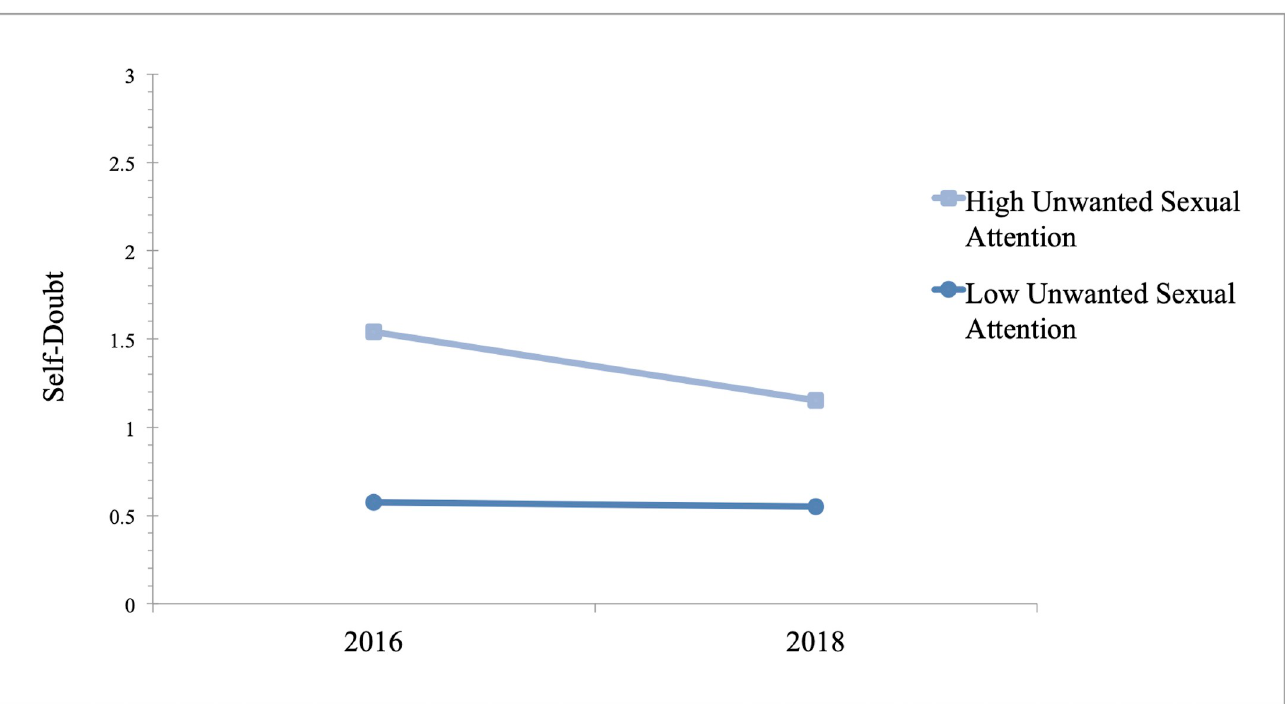
Fig 3. Coefficient estimates for relationship between unwanted sexual attention ( ± 1 SD) and self-doubt in 2016 and in 2018. Estimates are derived from GLM using data from 513 women, 250 of whom were surveyed in September 2016 and the remaining women were surveyed in September